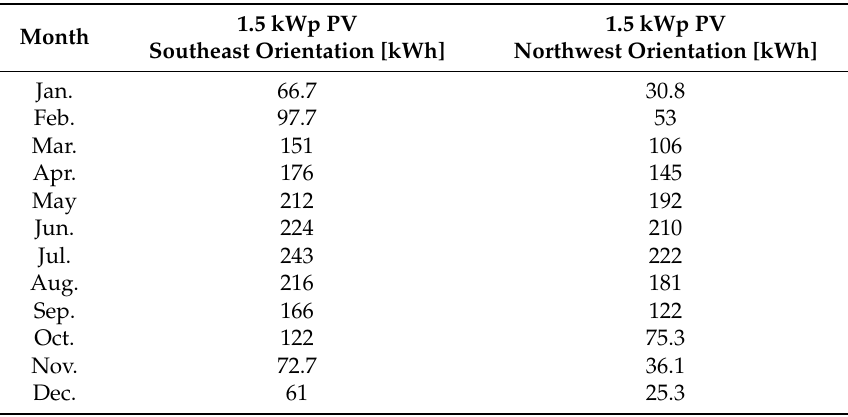
Table 2. Average monthly electricity production from the